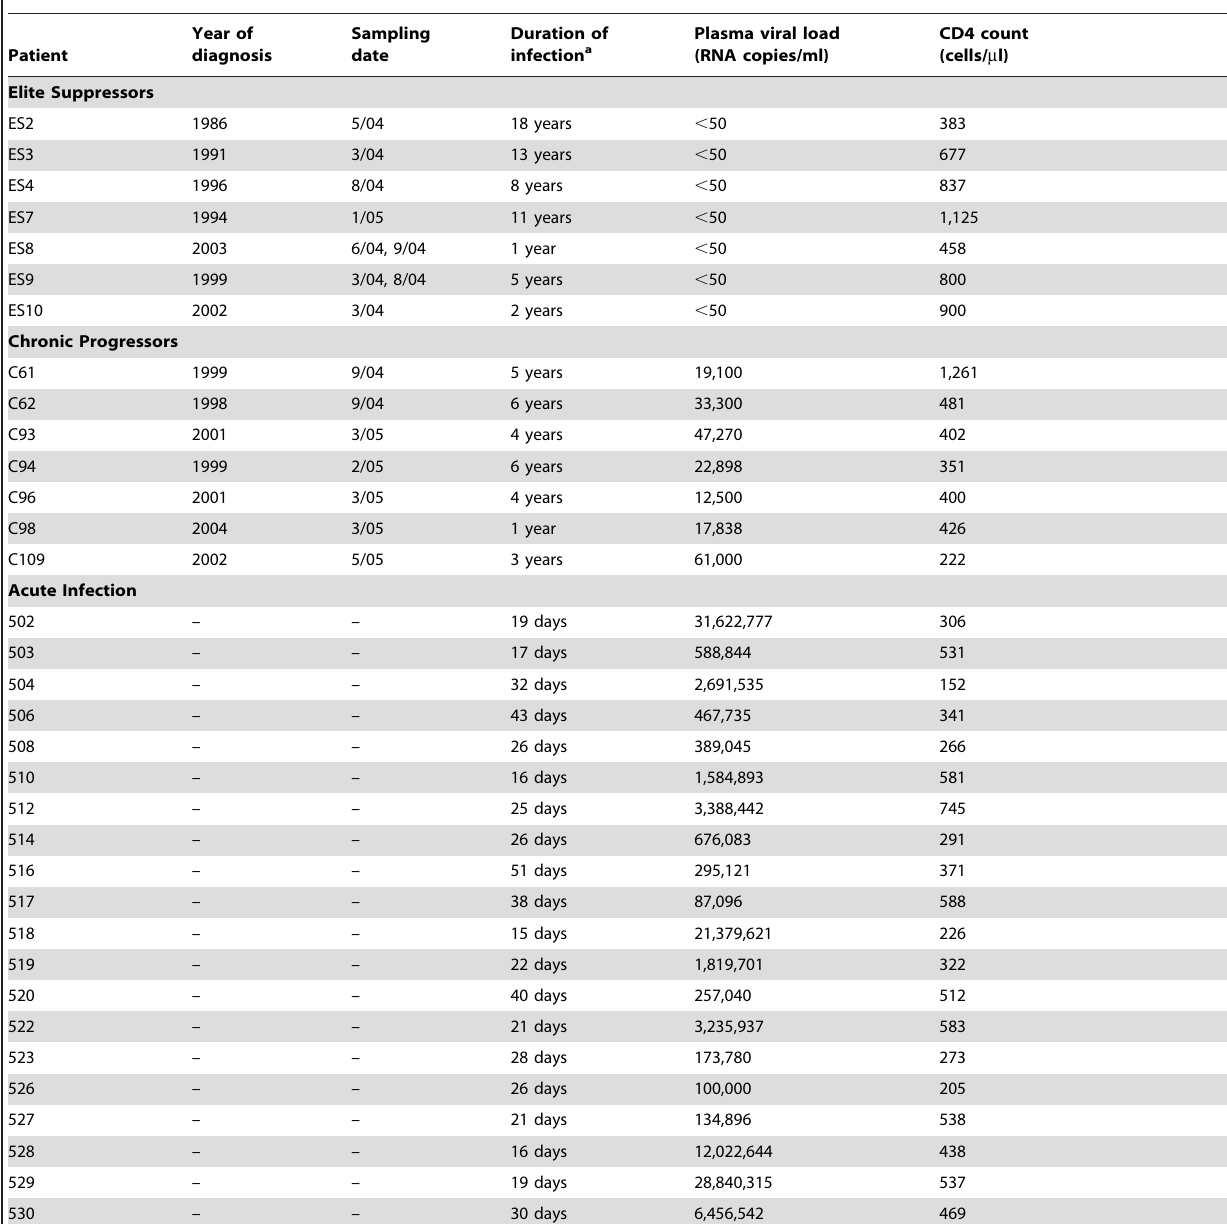
Table 1. Patient characteristics of elite suppressors, chronic progressors, and acutely infected